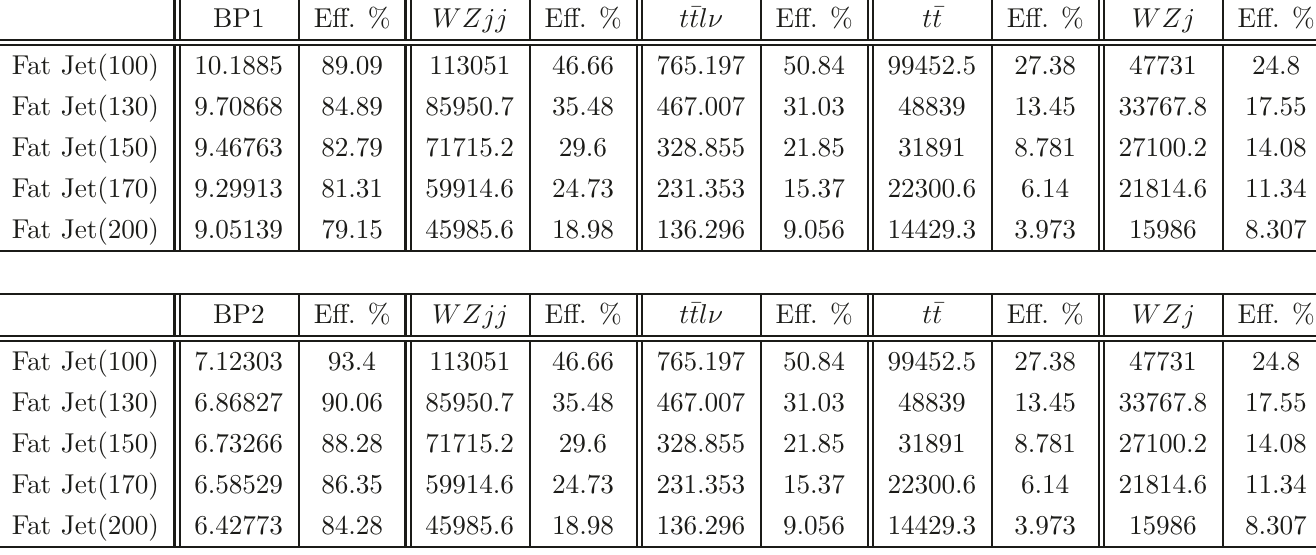
= 300 fb − 1 . Fat jet definition (first column) and efficiencies for L